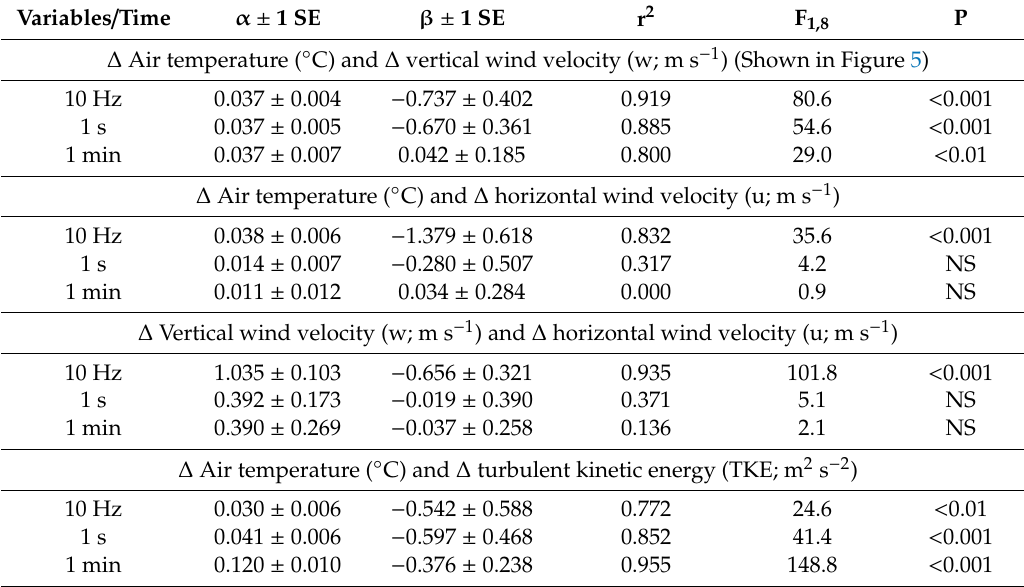
Table 5. Linear models of maximum di ff erences ( ∆ values) for air temperature, vertical wind velocity, and horizontal wind velocity measured at 10 Hz and integrated over 1 s and 1 min averaging times on towers in burn areas and control stands during the eight prescribed fires. Data were fit to the equation y = α × (variable) + β . NS = not